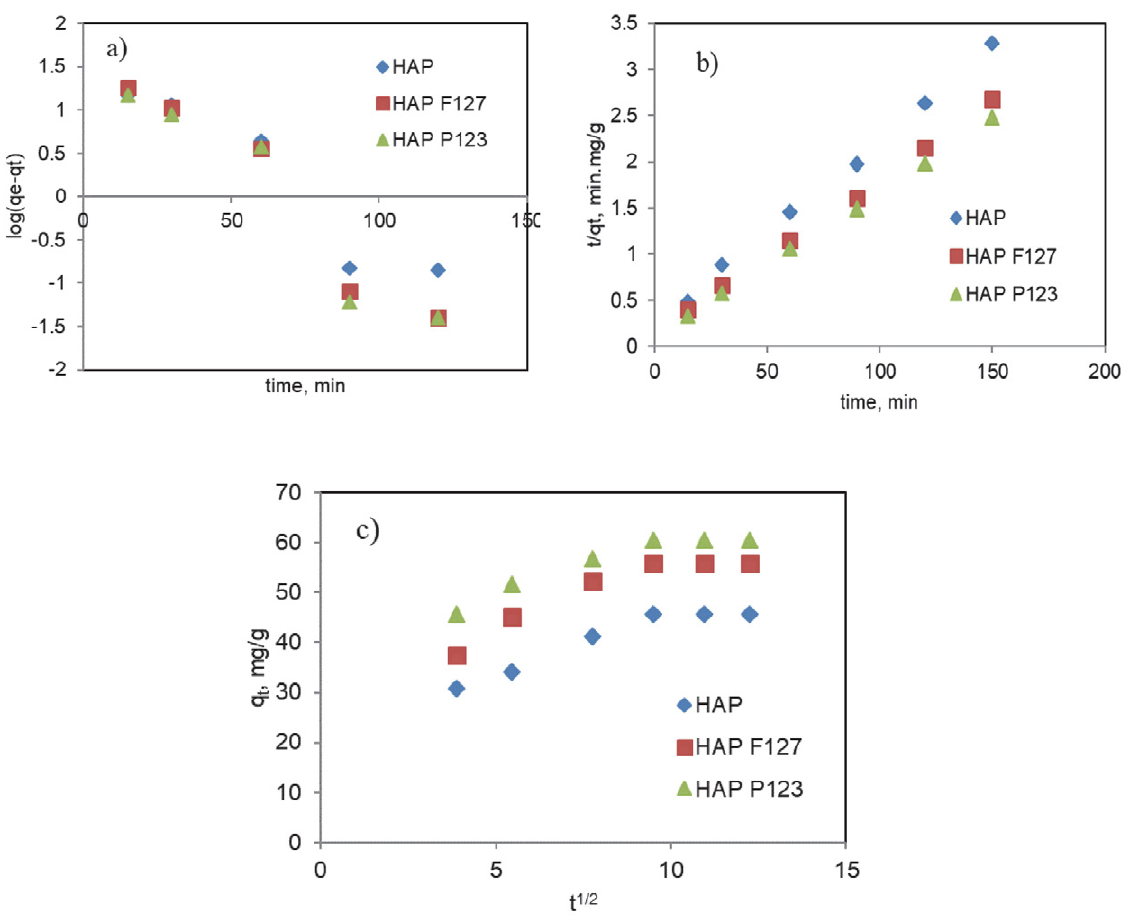
Figure 9. Pseudo-first order (a), pseudo-second order (b) and intraparticle diffusion kinetic model (c) for Al(III) adsorption onto investigated sor-